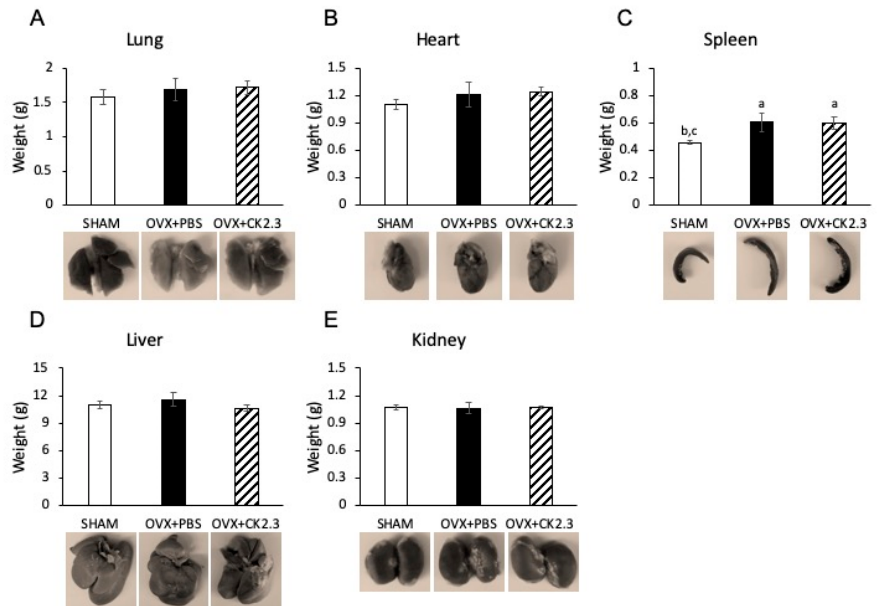
Figure 5. CK2.3 did not affect lung, heart, liver, spleen, and kidney of OVX rats. Mass of ( A ) lung, ( B ) heart, ( C ) spleen, ( D ) liver, and ( E ) kidney was similar in CK2.3-injected OVX rats to PBS-injected OVX rats. (a) Indicated a significant difference over SHAM, (b) indicated a significant difference over OVX+PBS, and (c) indicated a significant difference over OVX+CK2.3.